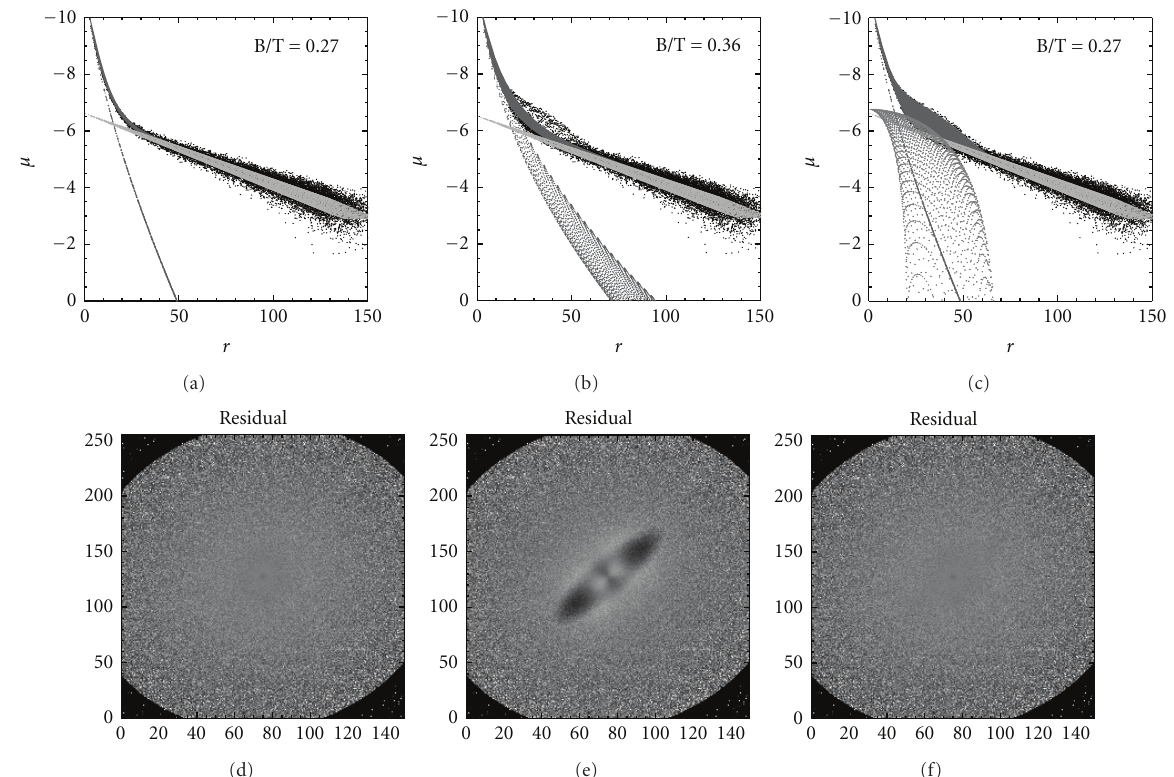
Figure 7: (a, b, c) surface brightness profiles of synthetic images in which noise is added to mimic a real image. In (a) the image has only a bulge and a disk, whereas in (b) and (c) a small bar is added on top of the disk. Black dots show the pixel values of the synthetic images, and the other symbols show the functions fitted to the 2-dimensional images, as explained in the text. (d, e, f) the residual images for the above decompositions are shown. They are obtained by subtracting the total decomposition model from the original synthetic image. The figure is a modified version of Figure 2 in Laurikainen et al.